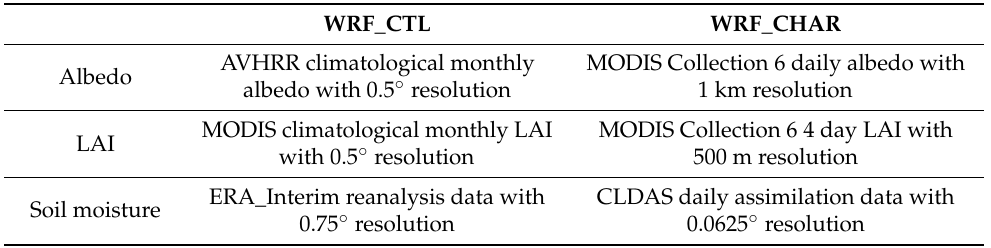
Table 1. Comparisons of LAI and albedo between WRF climatology and MODIS-derived datasets. WRF_CTL WRF_CHAR AVHRR climatological monthly MODIS Collection 6 daily albedo with Albedo albedo with 0.5 ◦ resolution 1 km resolution MODIS climatological monthly LAI MODIS Collection 6 4 day LAI with LAI with 0.5 ◦ resolution 500 m resolution ERA_Interim reanalysis data with CLDAS daily assimilation data with Soil moisture 0.75 ◦ resolution 0.0625 ◦